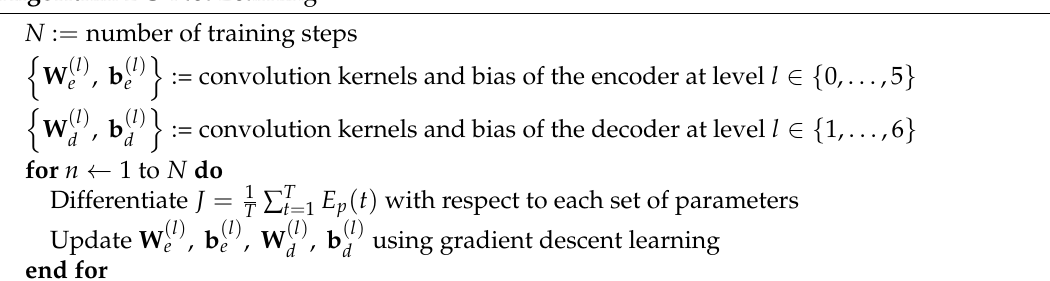
Algorithm 2 U-Net